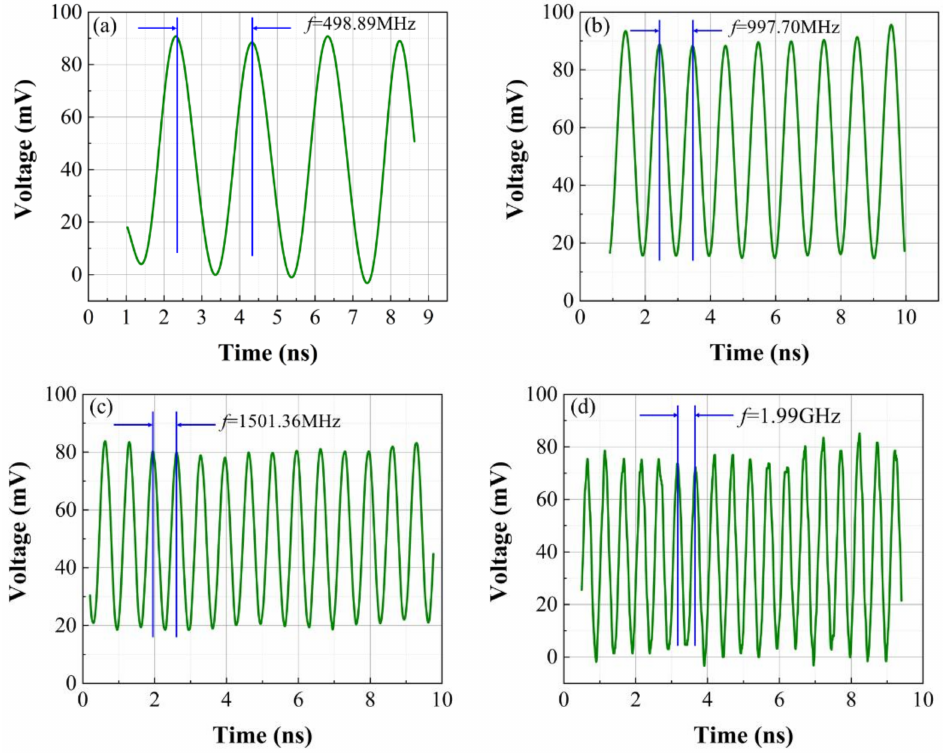
Figure 5. 500 MHz interval beat frequency output: ( a ) 500 MHz; ( b ) 1 GHz; ( c ) 1.5 GHz; ( d ) 2